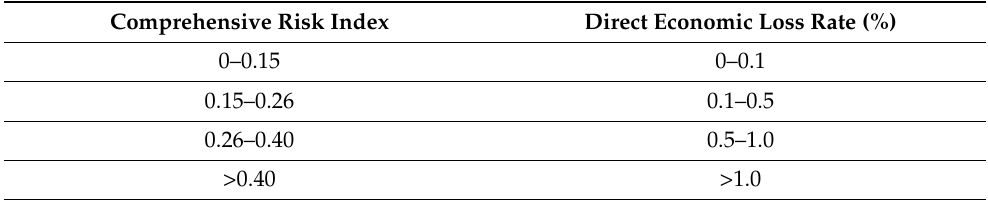
Table 3. CRIs and DELRs of flash floods in